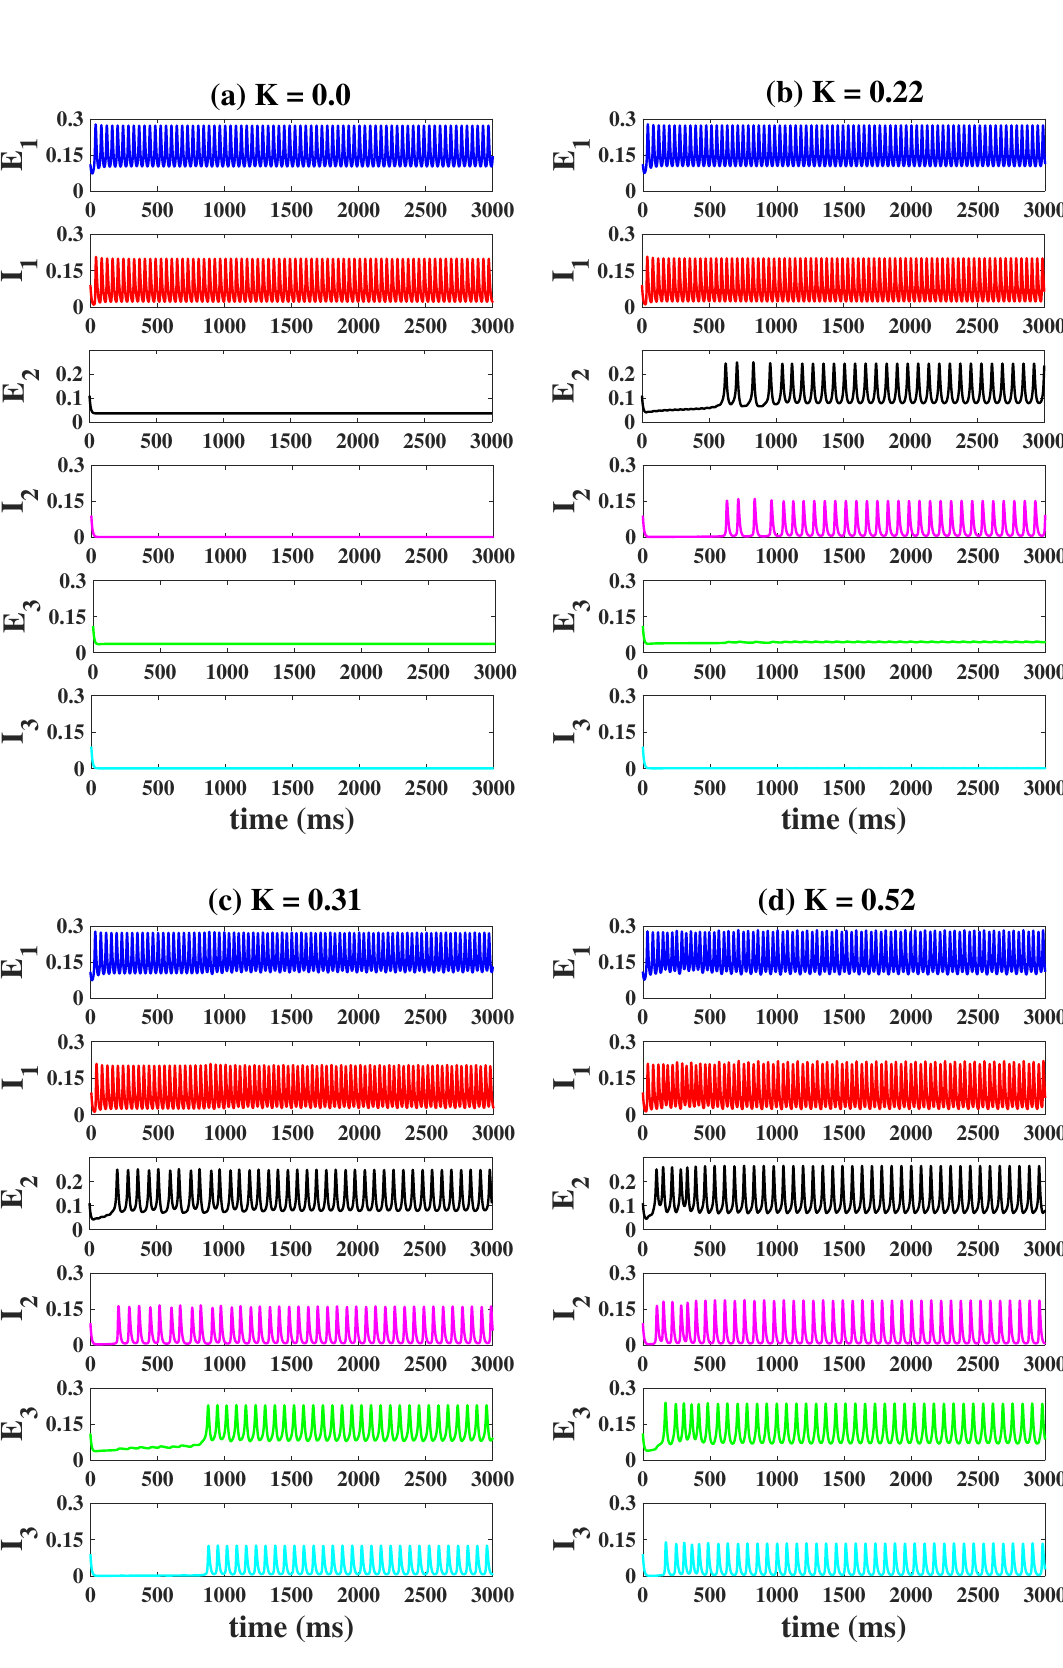
Figure 8. Time series of the three columns under different coupling connection strengths K . An increase in K will cause columns 2 and 3 to oscillate gradually ( b – d ), and column2 will oscillate before column3 ( b